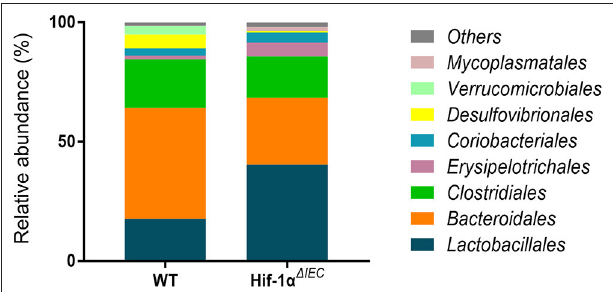
FIGURE 7 | Changes in the relative abundance of several bacterial phyla in Hif1- α ∆ IEC mice. Bacterial community of fecal samples from WT and Hif1- α ∆ IEC mice with DNA sequencing ( n = 6